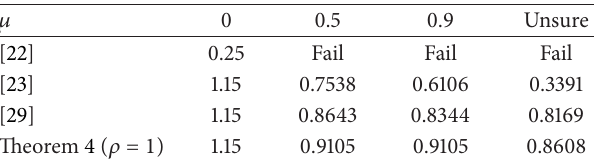
Figure 1: State response curves with 𝜏 = 1 and 𝜇 = 0 for Example 7. Table1:Allowableexponentialconvergencerate 𝑘 forvariable 𝜇 and 𝜏 = 1 .